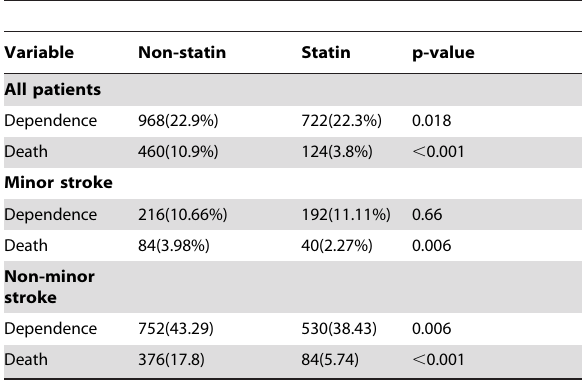
Table 2. Patient Functional Outcomes According to Statin Use at 3 Months.